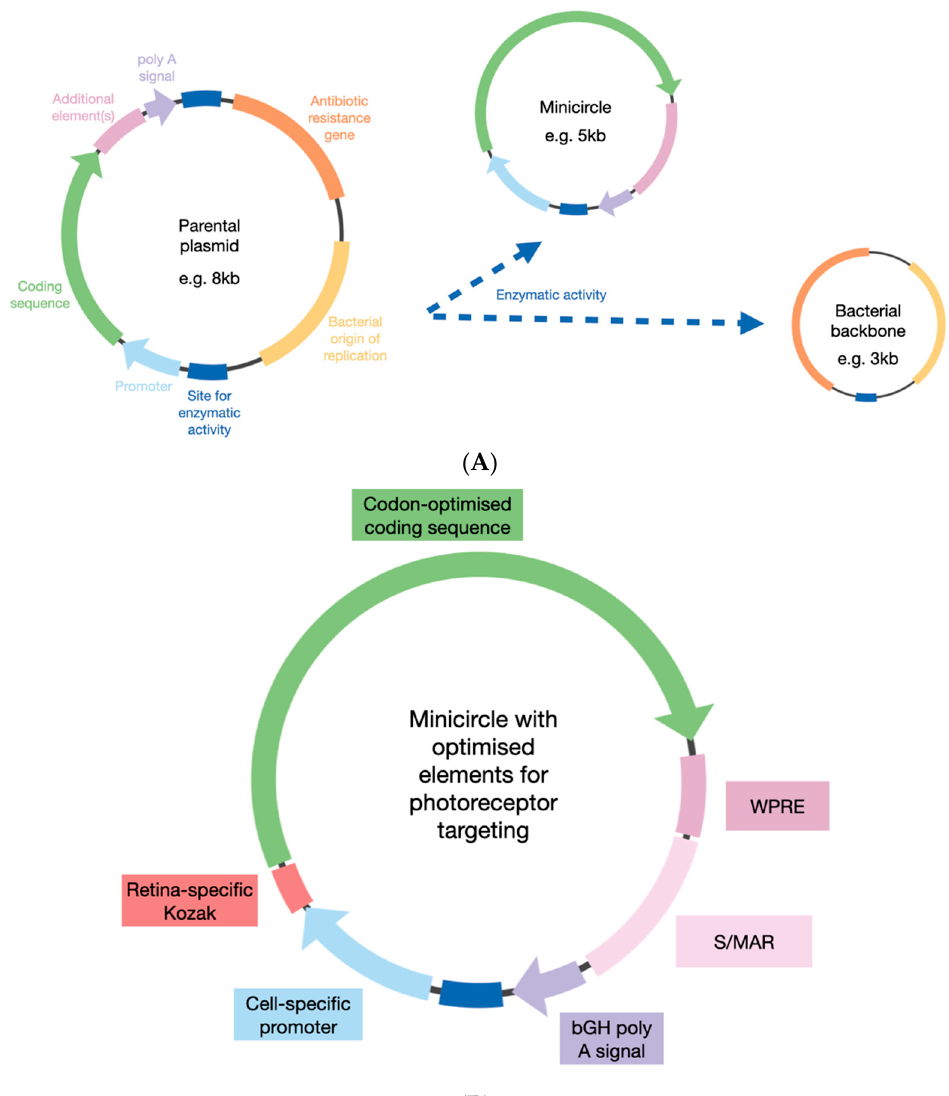
Figure 1. General principles in forming a minicircle from a parental plasmid. ( A ) The bacterial elements are removed from the parental plasmid by different enzymatic options (see main text). ( B ) The elements included in the minicircle can be optimised depending on the cell target, such as the photoreceptor cells. bGH = bovine growth hormone; S/MAR = scaffold matrix attachment region; WPRE = Woodchuck hepatitis virus post-transcriptional regulatory element.